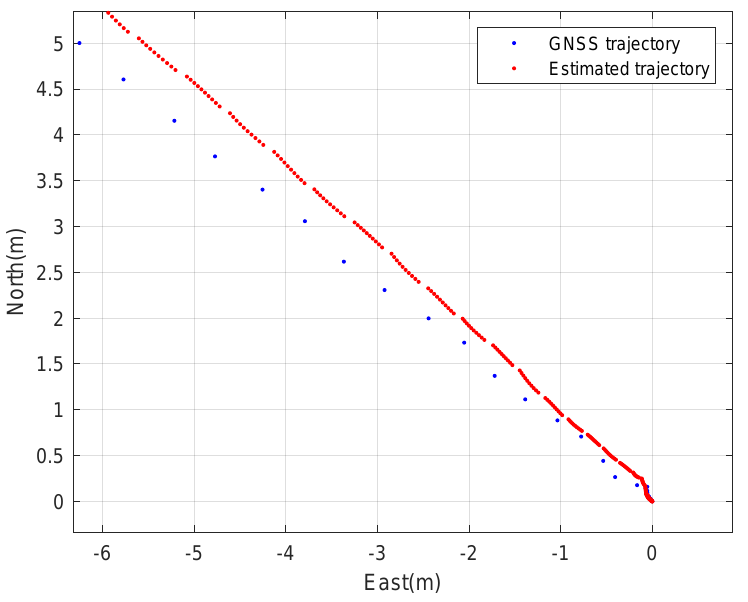
Figure 16. The expanded 2D trajectory of the athlete. Figure 18 shows the three-axis velocities of the athlete. The blue lines represent the measured GNSS velocities data and the red lines represent the estimated three-axis veloci- ties using the designed integration filter. The estimated results and the GNSS measured results are similar as shown in Figure 18. The z-axis velocity estimated using the designed integration filter has errors. This is because the IMU in the wearable EPTS might react when the athlete started a spurt.